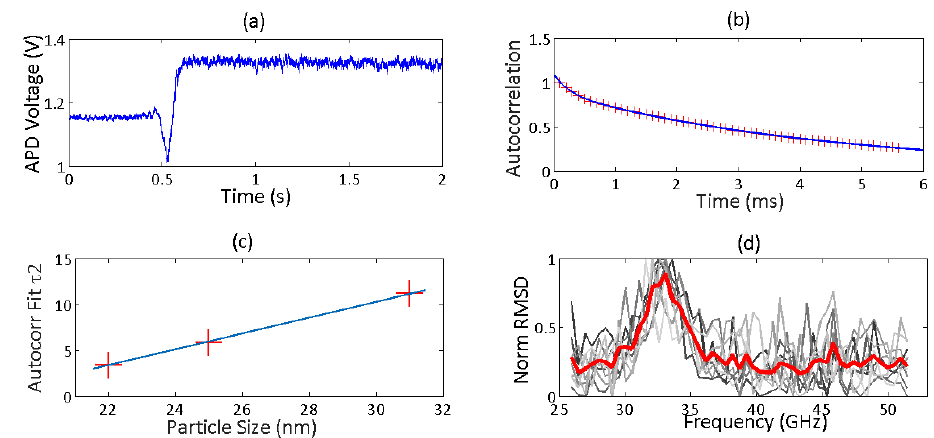
Figure 2. Sizing of particles via autocorrelation analysis: ( a ) a typical signal of a trap event; ( b ) autocorrelation of the signal after trapping, with double-exponential fit curve to extract the time constant, τ 2; ( c ) a linear fit of the values of the time constant obtained from the autocorrelation curve fit, τ 2 vs. particle diameter for the three particle sizes; ( d ) eight measurements of the extraordinary acoustic Raman (EAR) signal of PhiX174 virus, along with the averaged curve in red, showing a peak at 32 GHz.